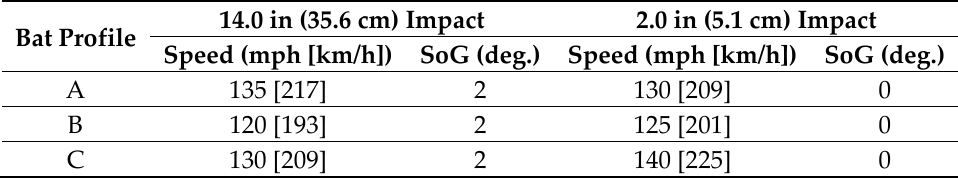
Table 4. Peak speed and associated slope of grain (SoG) for NF outcome.